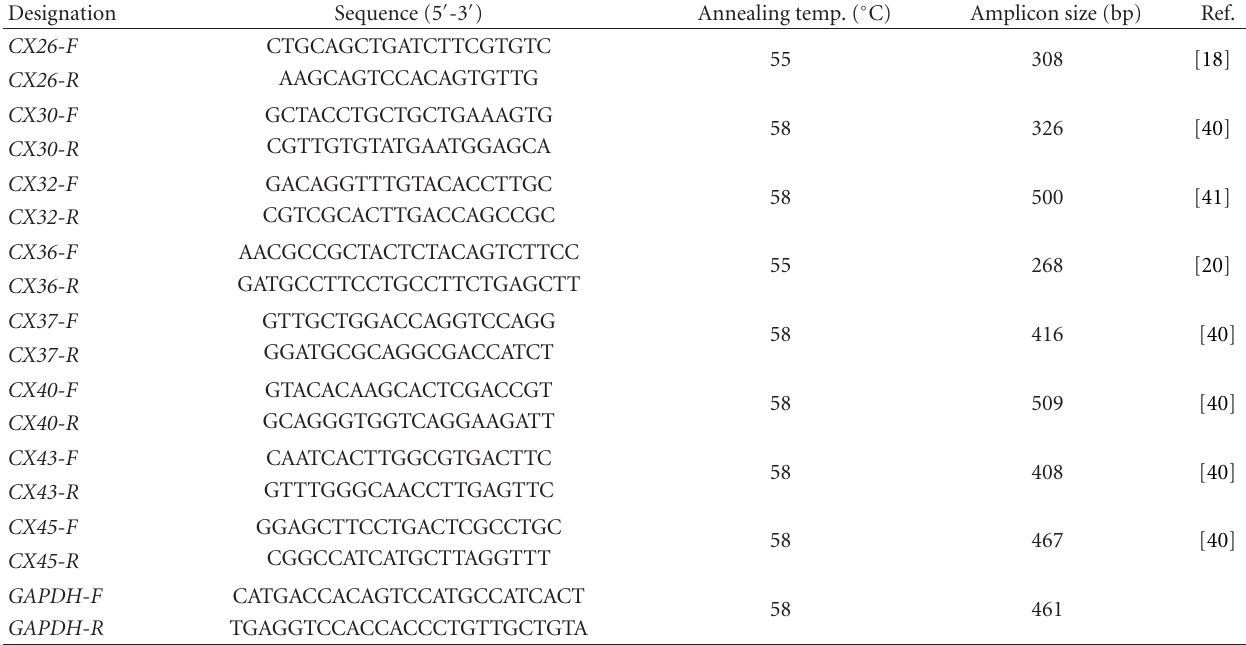
Table 1: Sequence and annealing temperatures for